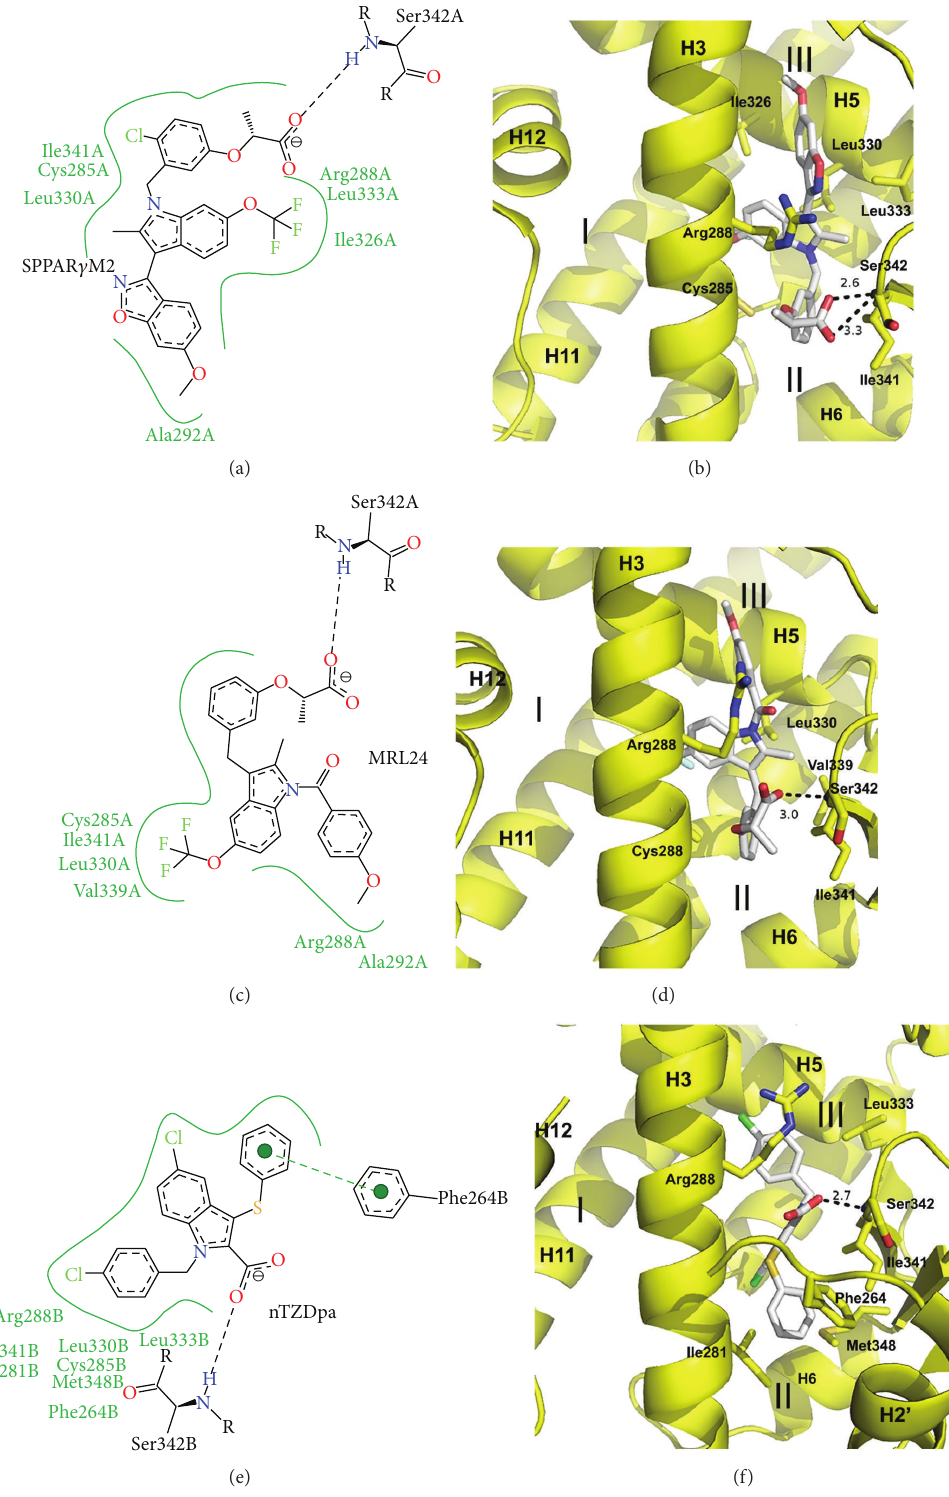
Figure3:CrystalstructuresofindolecontainingPPAR 𝛾 partialagonists.(a)PoseviewmapofSPPAR 𝛾 M2.(b)CrystalstructureofSPPAR 𝛾 M2 bound to the PPAR 𝛾 ligand binding domain. PDB: 2P4Y [50]. (c) Poseview map of MRL24. (d) Crystal structure of MRL24 bound to